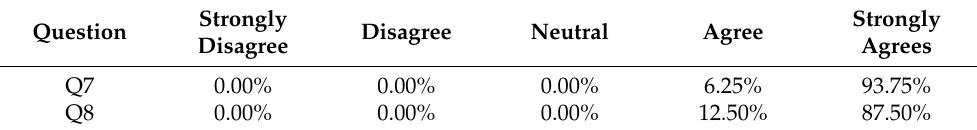
Table 5. Q7, Q8—Hypothesis 3.